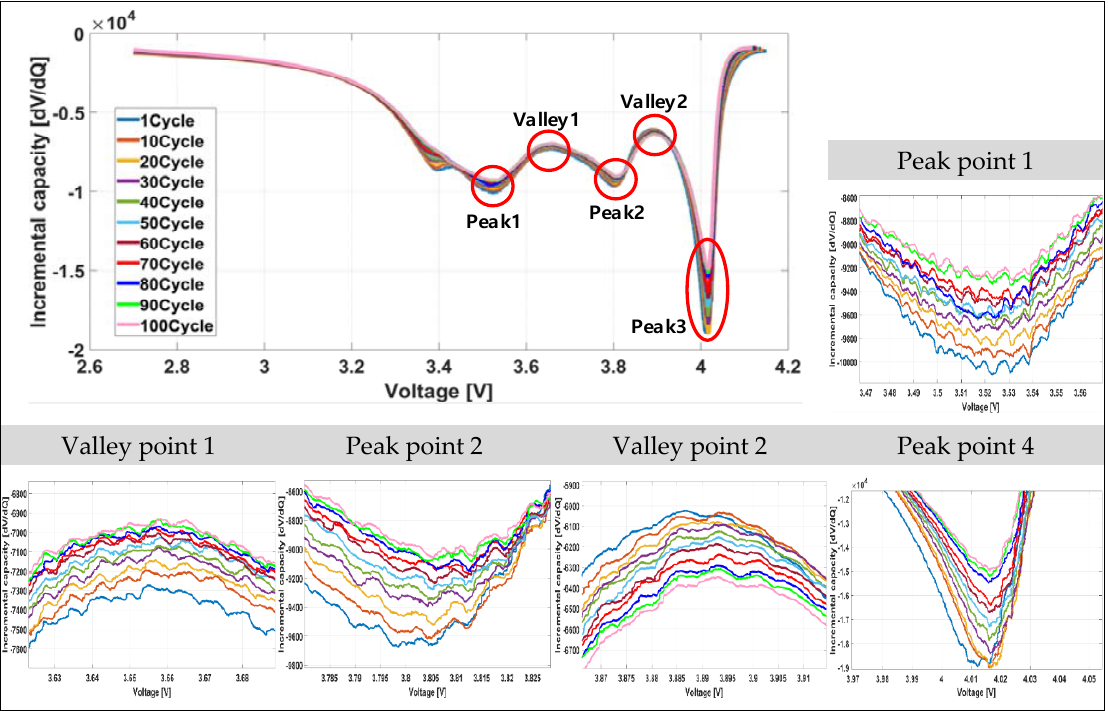
Figure 10. IC curve and three detailed peak points and two valley points of the fresh cell no. 1 according to the aging cycle test.